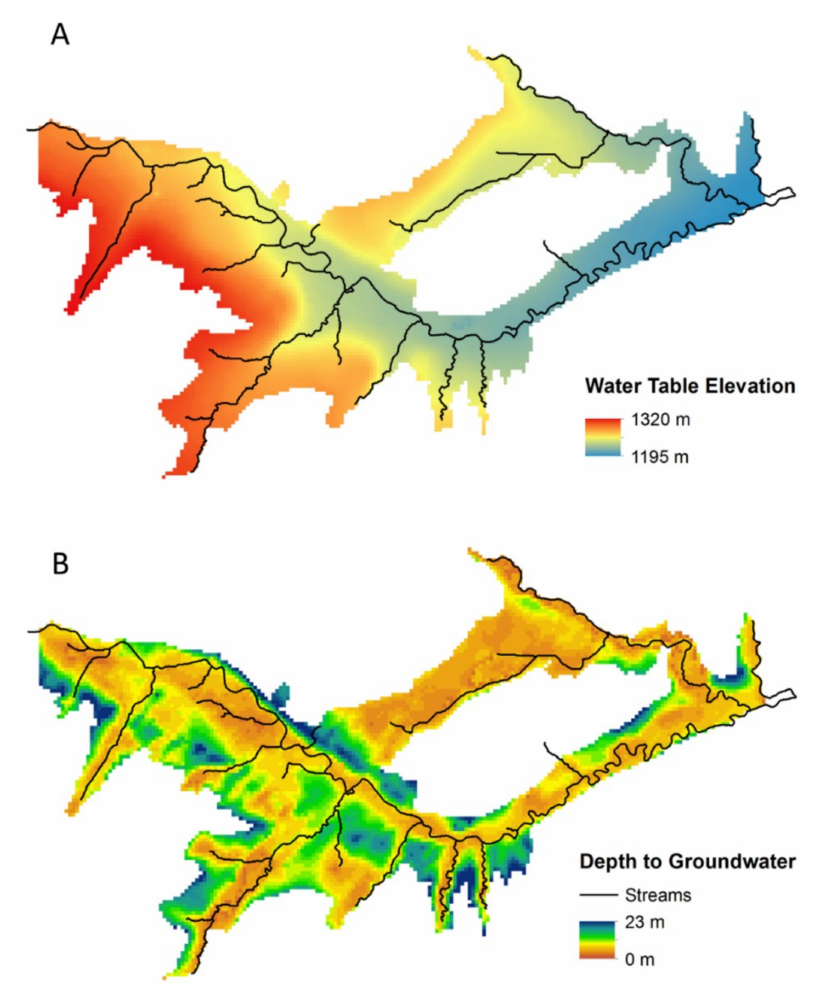
Figure 8. Annual average cell-wise plots for active MODFLOW grid cells in the study region over the 1999–2016 time period: ( A ) water table elevation and ( B ) depth to groundwater